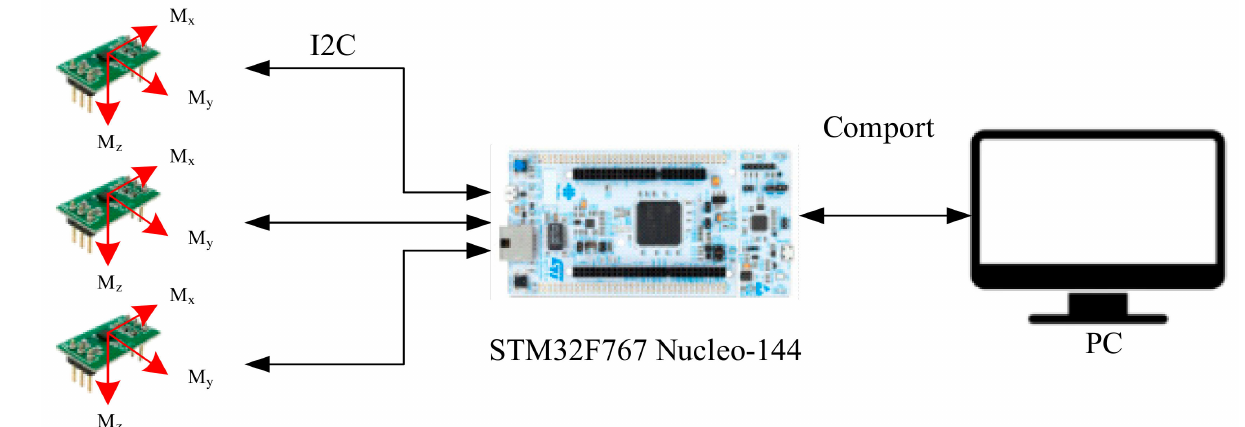
Figure 4. Embedded magnetic sensing array development platform.